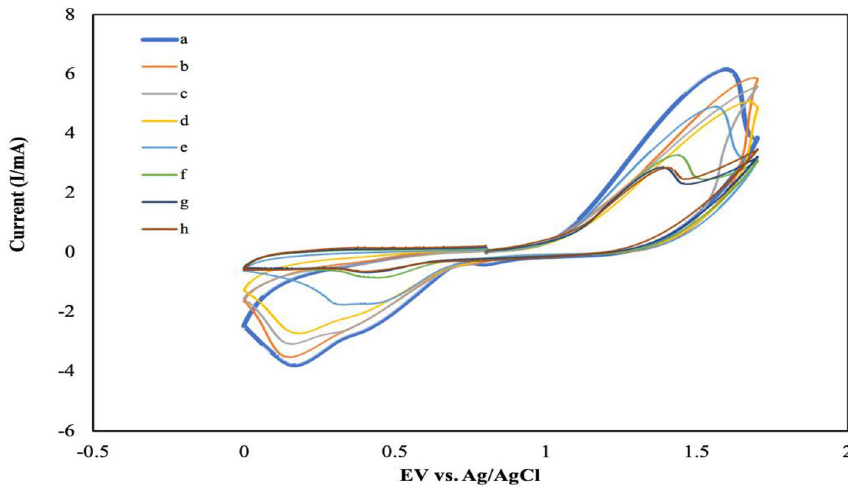
Figure 5. Cyclic voltammogram’s effect of different pH values tested on f-MWCNTs/CS/PB/AuE; ( a ) pH 2, ( b ) pH 3, ( c ) pH 4, ( d ) pH 5, ( e ) pH 6, ( f ) pH 7, ( g ) pH 8 and ( h ) pH 9 under scan rate of 250 mVs -1 for 5 s accumulation time in the presence of 3 ppm of Zn 2+ ( n =